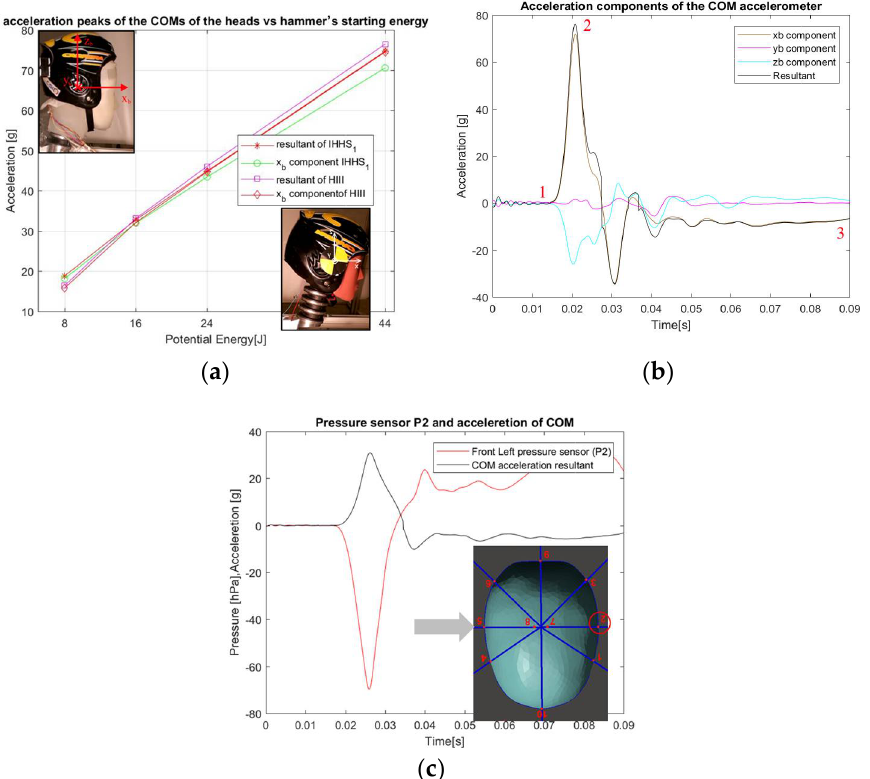
Figure 4. Pilot tests results. ( a ) Comparison between IHHeadS_1 and HIII in back impacts tests; ( b ) Example of three acceleration components at the brain CoM after a 44 J back impact test; ( c ) CoM acceleration and fluid depression wave during right side impact on surrogate IHHeadS_1 at 16 J (top